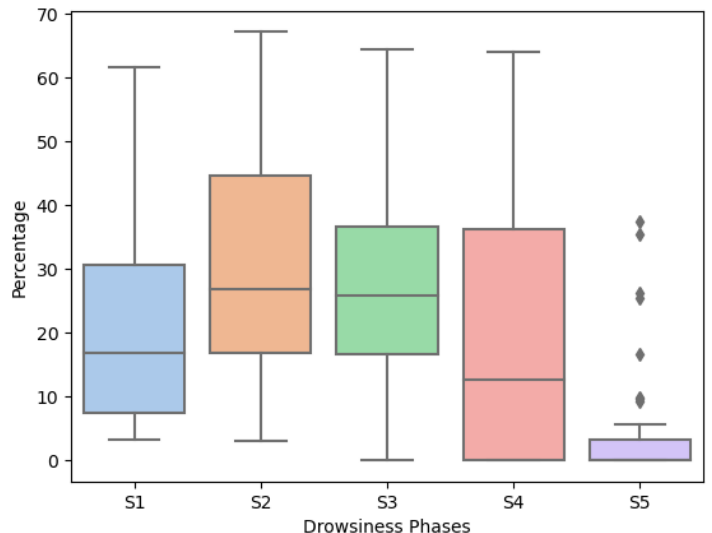
Figure 4. Percentage of Each Drowsiness